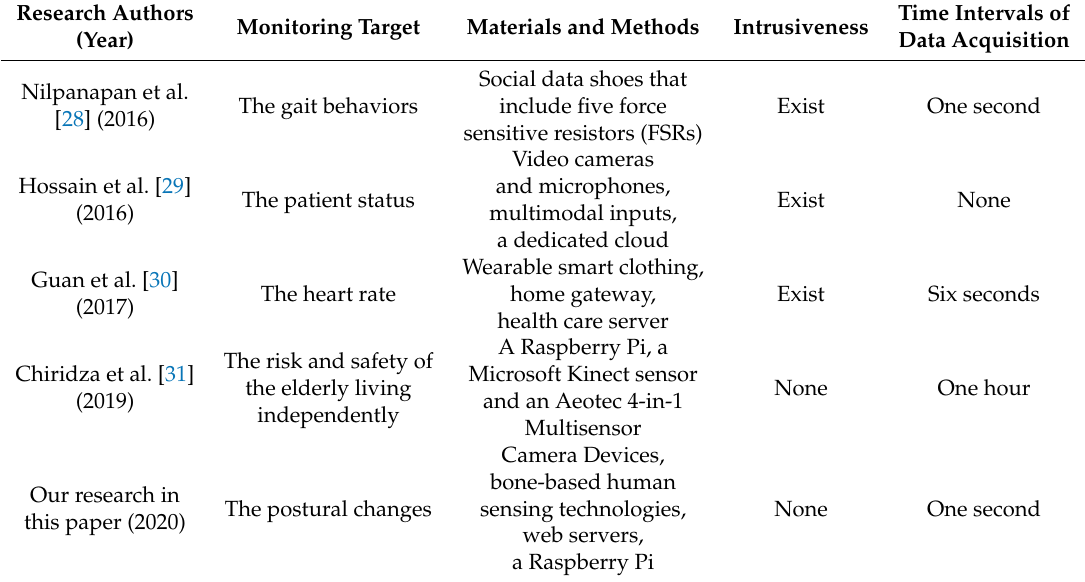
Table 1. A comparison of related work for home